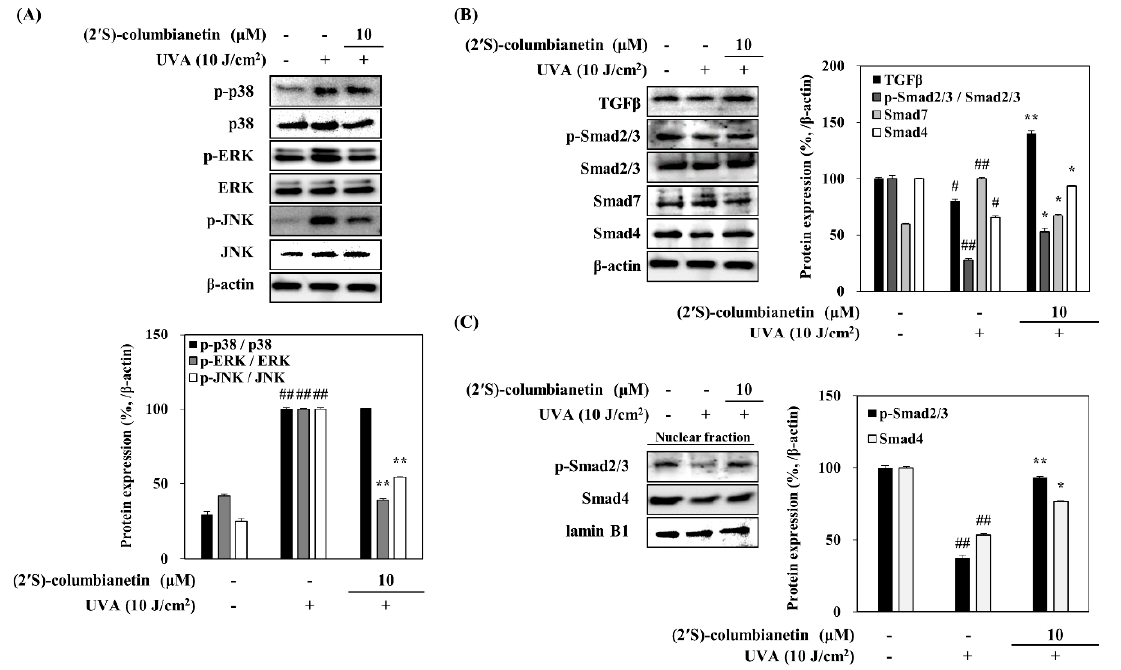
Figure 5. Effect of (2 ′ S)-columbianetin on the protein levels of; total and phosphorylated (p-) p38, ERK and JNK MAPKs ( A ), TGF β , Smad2/3 (total and p-), Smad7 and Smad4 ( B ), and nuclear levels of p-Smad2/3 and Smad4 ( C ) in UVA irradiated HDFs following 24 h treatment. Protein levels were observed by Western blotting. Bands were quantified densitometrically and shown as relative percentage of UVA-irradiated untreated control group. β -actin and lamin B1 were used as internal loading control. Values are means ± SD ( n = 3). # p < 0.05, ## p < 0.01 compared to non-irradiated blank group; * p < 0.05, ** p < 0.01 compared to UVA-irradiated untreated control group.